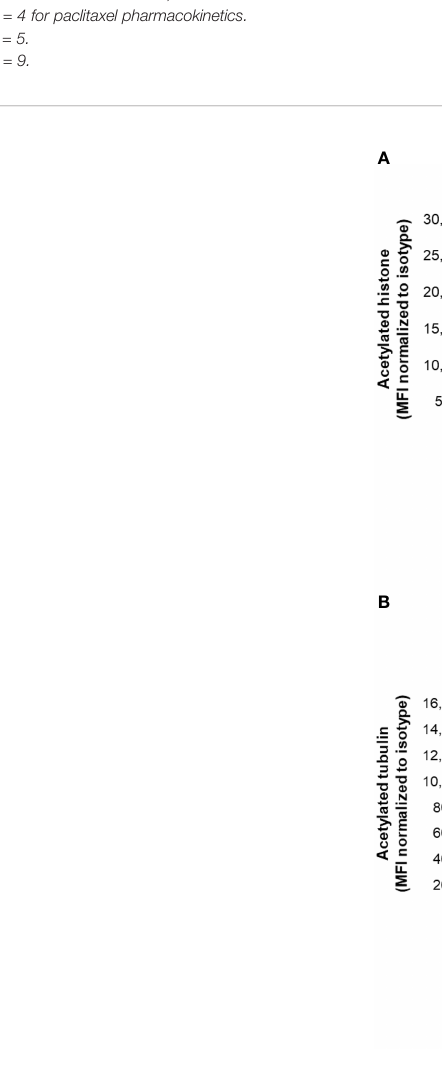
FIGURE 3 | Histone (A) and tubulin (B) acetylation time course (average and SEM for patients treated at indicated levels on cycle 1 day 1). Dose levels indicated are 180, 360, and 480 mg of citarinostat orally once daily. Note: measurements are made on n = 3 at 180-mg level, n = 11 at 360-mg level, and n = 6 at 480-mg level. Cycle 1 day 15 measurements have similar pro fi les (data not shown). ACY, ACY-241 (citarinostat); MFI, mean fl uorescence intensity; PTX,